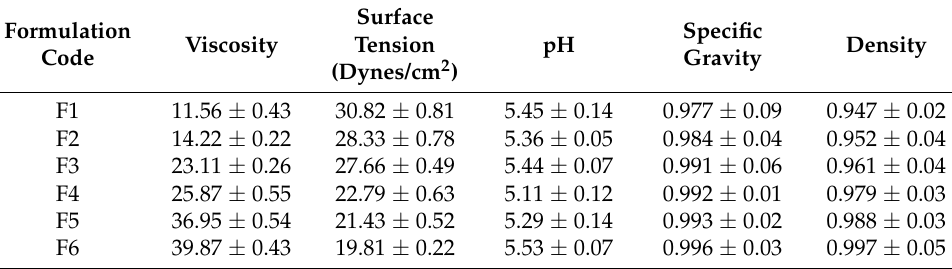
Figure 2. Particle size distribution of optimized SLN formulations using DLS analysis. Table 3. Viscosity, specific gravity, Surface tension, pH, and density of prepared SLN